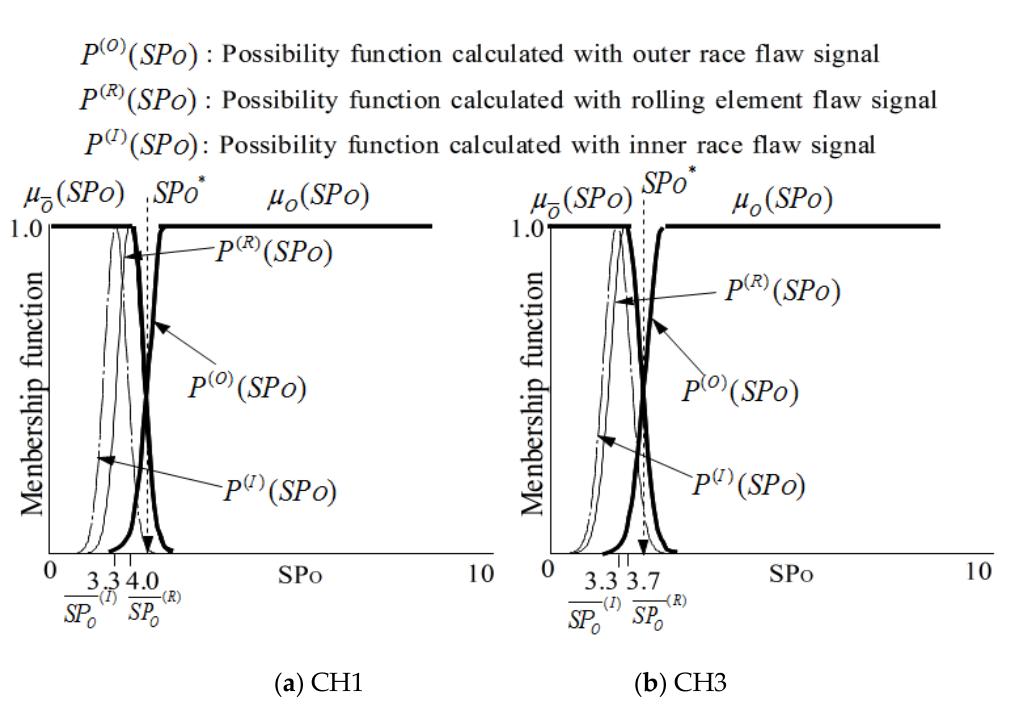
Figure 5. Membership functions 𝜇 O (𝑆𝑃 𝑂 ) and 𝜇 O̅ (𝑆𝑃 𝑂 ) for recognition of outer race flaw.